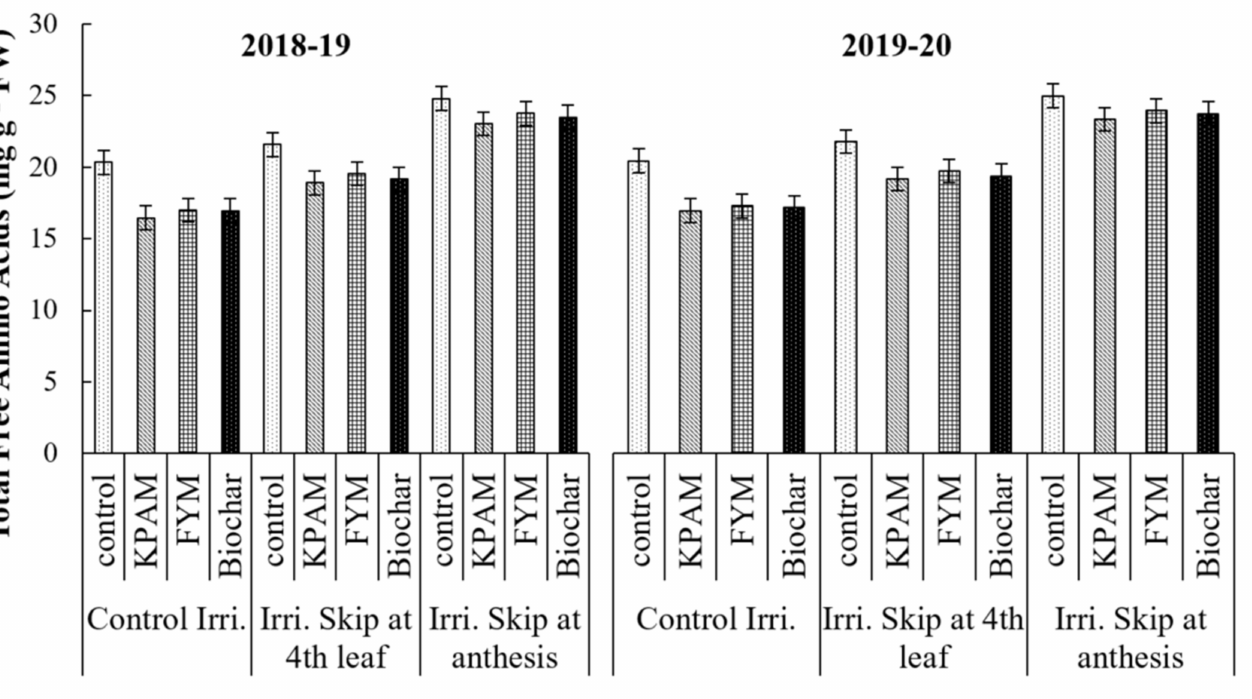
Figure 10. Effect of soil amendment materials on total free amino acids in the wheat crops grown under normal and water stress imposed by skipping irrigation at 4th leaf and anthesis stage of growth (mean values ±